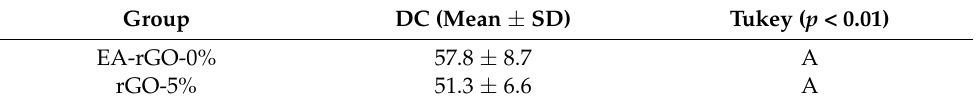
Table 3. Degree of conversion (DC) displayed by EA-rGO-0% and rGO-5% adhesive.